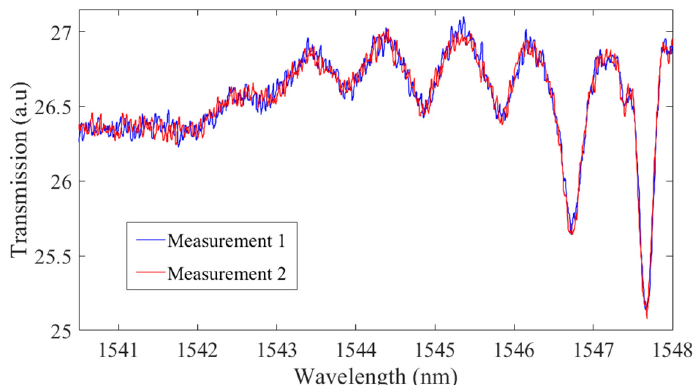
Figure 8. Higher cladding resonance peaks in the TFBG spectrum of two consecutive measurements using 1.40 RI liquid.